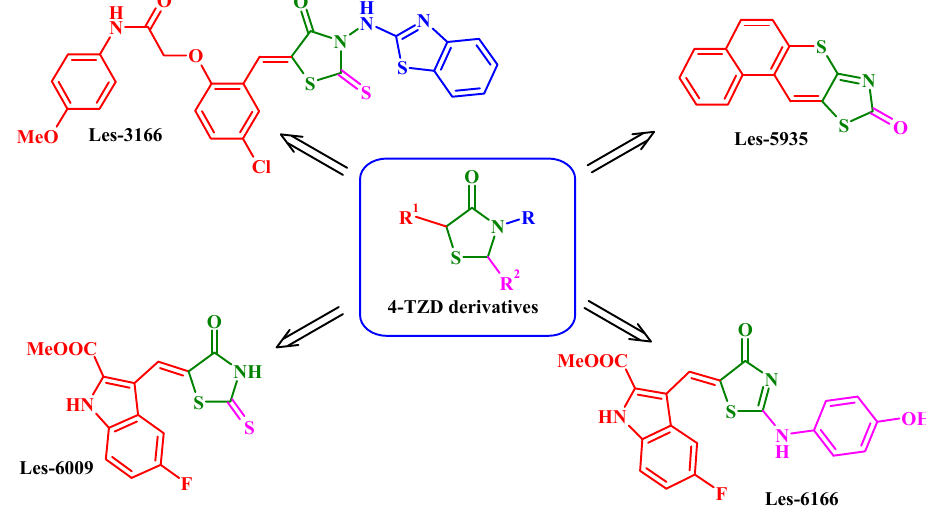
Figure 1. Structure of studied compounds.